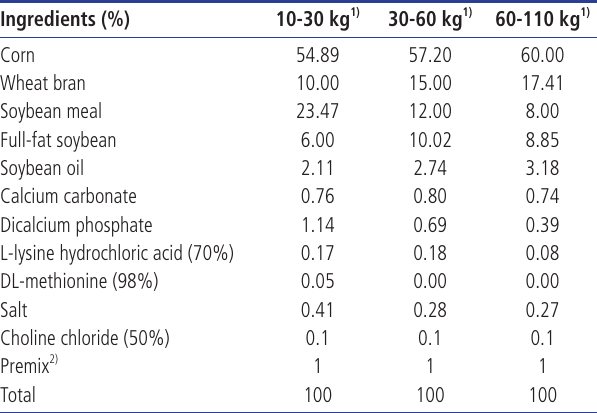
Table 1. Ingredients of the diets for pigs at the three stages